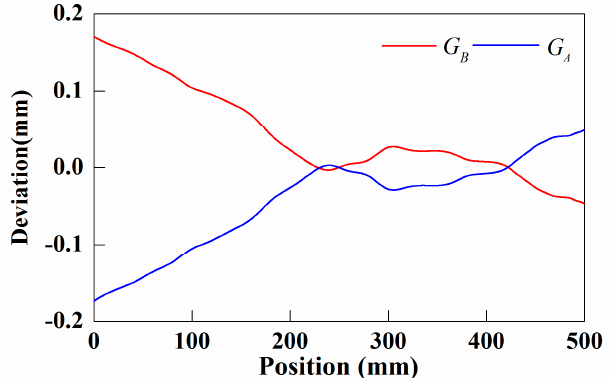
Figure 26. Two positional relation curves.